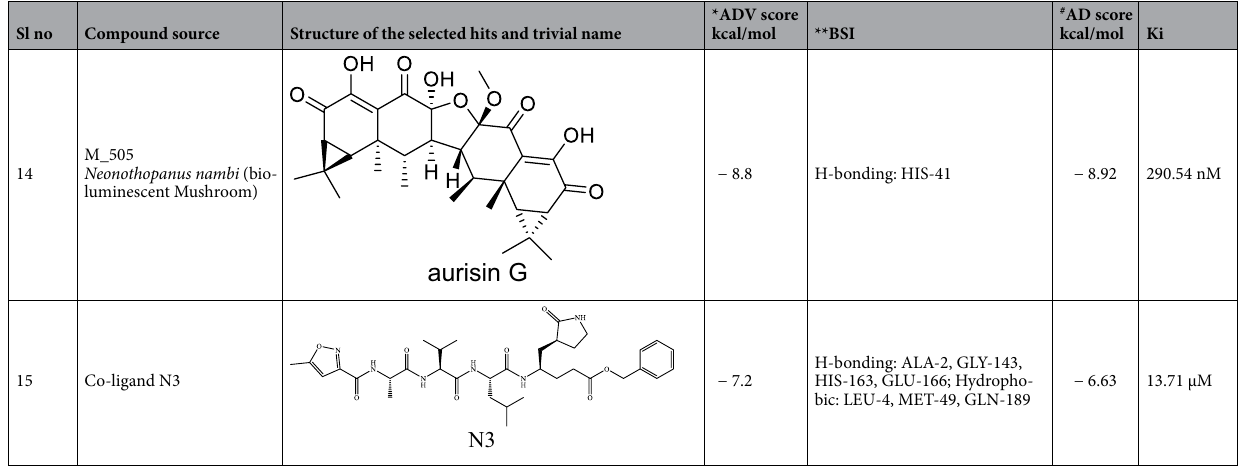
Table 1. Source mushroom of the c ompounds, the structure of the top fourteen hits, trivial name of the compounds, docking score (*ADV = Auto Dock Vina, ** BSI = Binding Site Interaction, # AD = Auto Dock 4.2), interacting active site